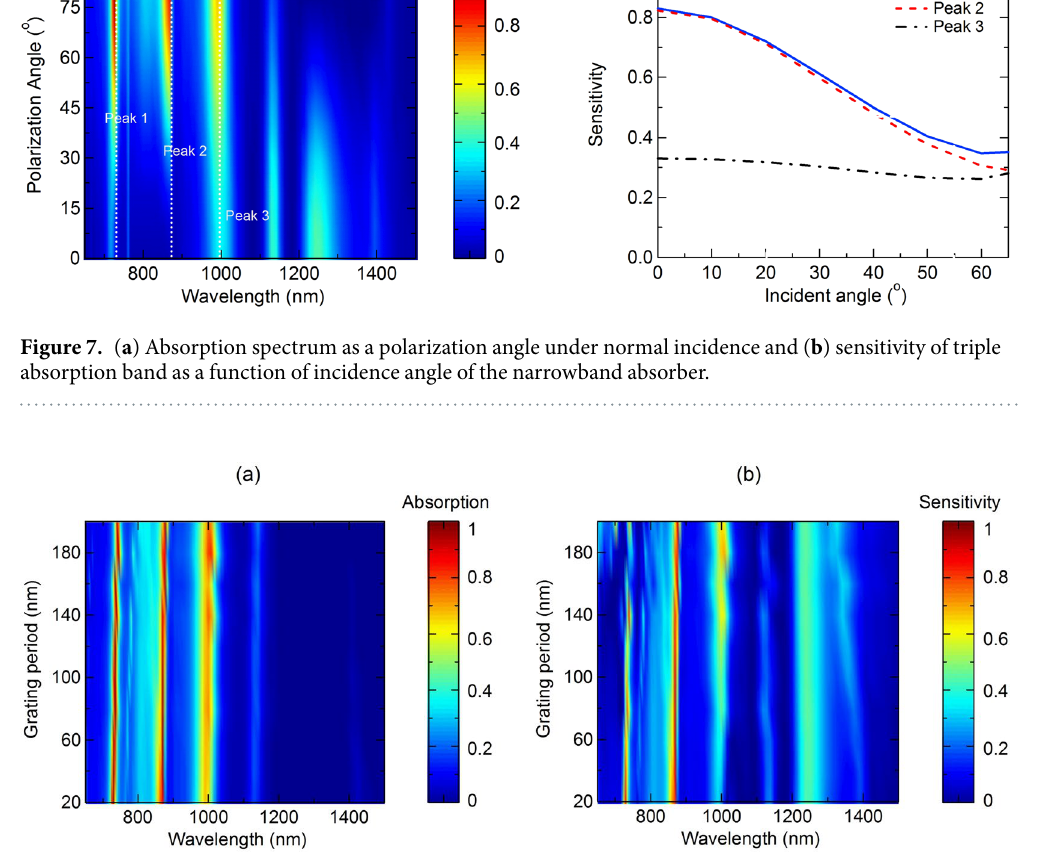
Figure 8. ( a ) Absorption spectrum for s-polarization and ( b ) polarization sensitivity spectrum of the narrowband absorber as a function of the grating period.